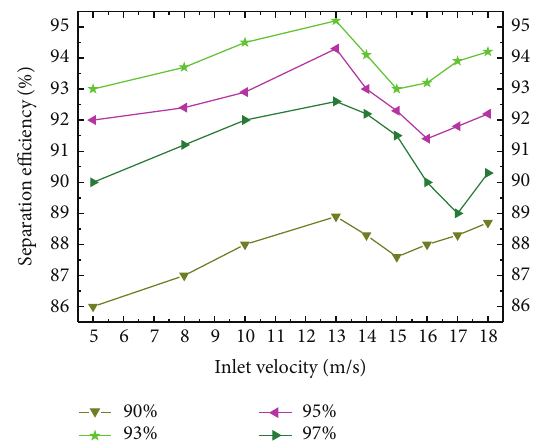
Figure 3: The influence of the inlet velocity on separation efficiency under different gas void